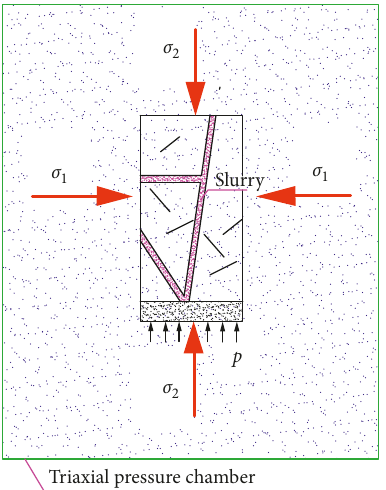
Figure 6: Stress state of pregrouting rock pillars in the pressure